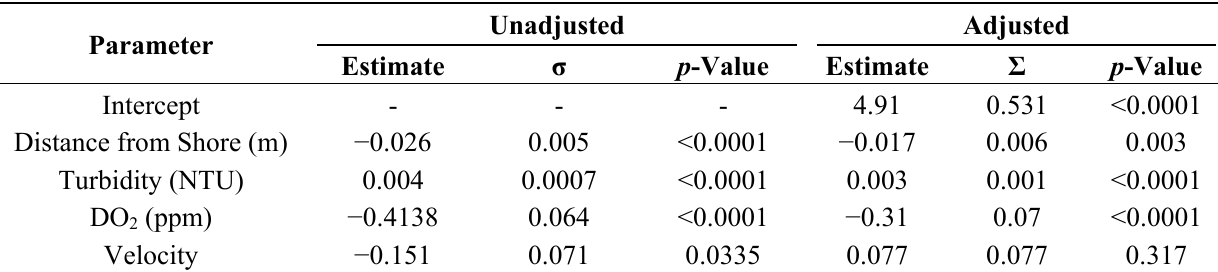
Table 3. Final unadjusted (univariate) and adjusted (multivariate) correlated mixed model assessing factors associated with log 10 E. coli concentrations. Samples were correlated at the transect